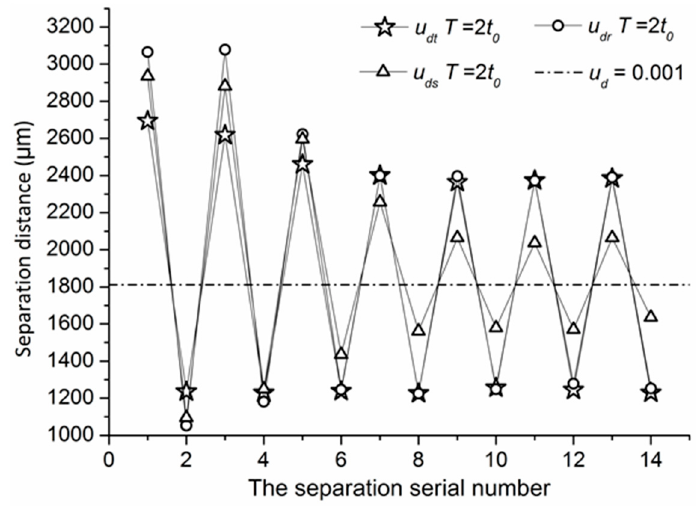
Figure 11. Separation distance obtained from numerical simulations for dynamic dispersed injection flow rate of different types.